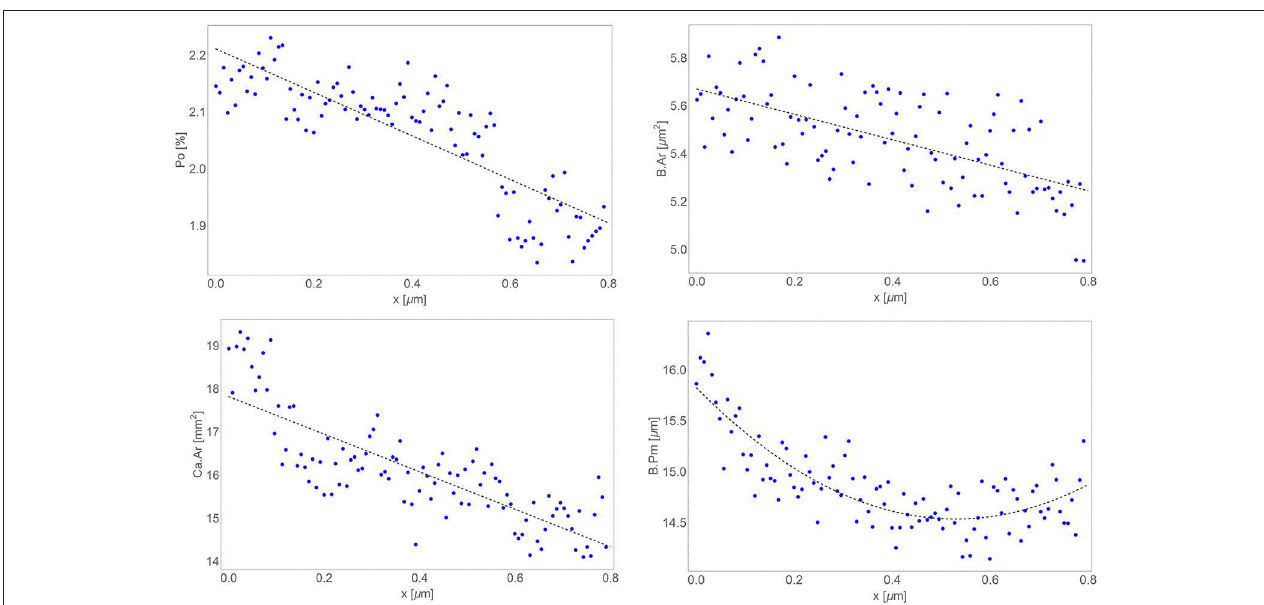
FIGURE 4 | Distribution in longitudinal direction of results (blue dots) and their trends (dashed line): porosity (upper left), bone area (upper right), canal area (bottom left), and bone surface (bottom right).